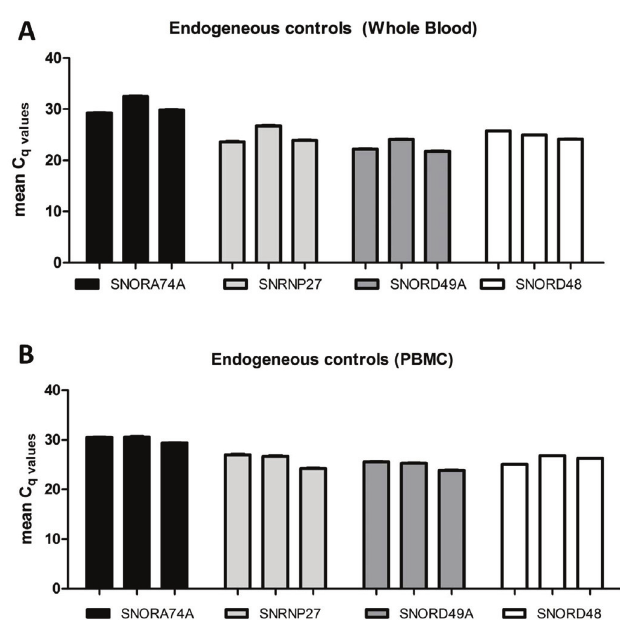
Figure 3. Expression of endogenous controls in total RNA extracted. A panel of four stably expressed miRNAs were selected and quantified to identify the most stable control for normalisation of miR-146a-5p and miR-155-5p in paired samples (n=3) ( A ) whole blood and ( B ) PBMCs. The standard error of the mean is shown by the error bars for demonstration of technical variability.